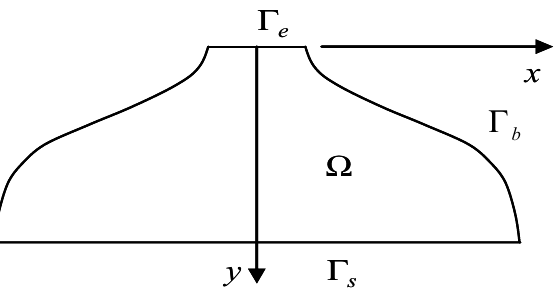
Figure 22. Scheme of the bilayer coextrusion die geometry.